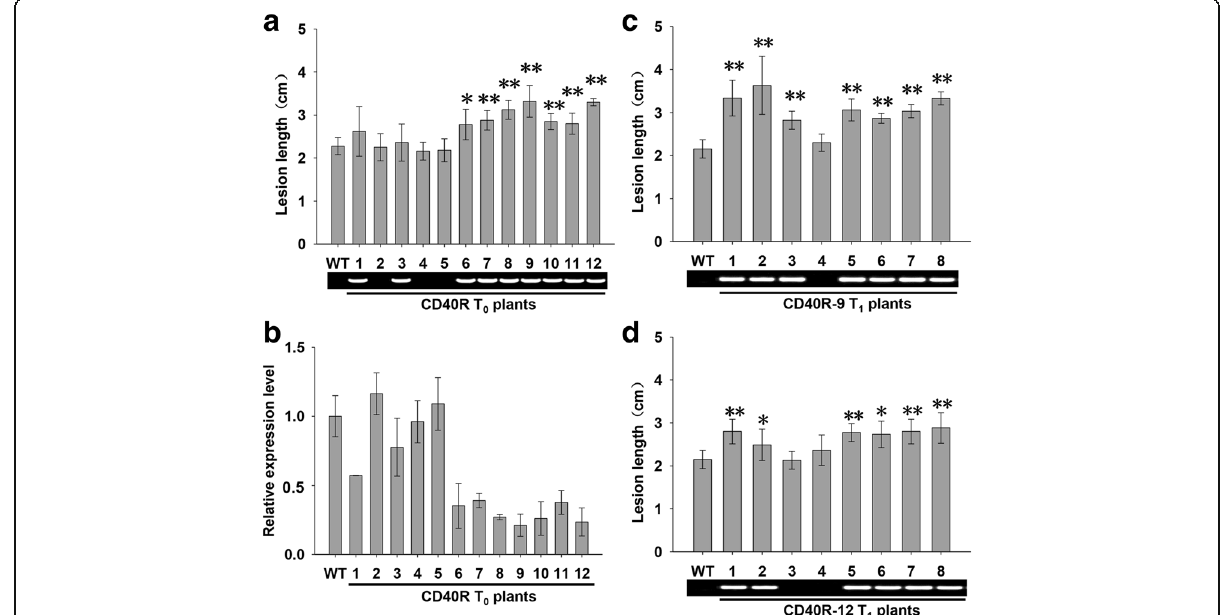
Fig. 3 Repressing OsHsp18.0-CI expression enhances susceptibility to Xoc . a Lesion lengths of the 12 individual T 0 transgenic plants with ds1301:: OsHsp18.0-CI (CD40R). b Relative expression levels of OsHsp18.0-CI in the T 0 transgenic plants. c and ( d ) The progeny of two T 1 lines (CD40R-9 and CD40R-12) showed significant reductions in lesion length after inoculation with Xoc . The average lesion length for each plant was measured at 10 to 15 inoculation sites at 14 dpi. The gel graph indicates the plants carrying ds1301:: OsHsp18.0-CI that were validated by PCR. The bars represent the means ± SD. “ * ” and “ ** ” indicate significant ( t test, P < 0.05) and extremely significant ( t test, P < 0.01) differences in lesion lengths between wild-type and transgenic plants,